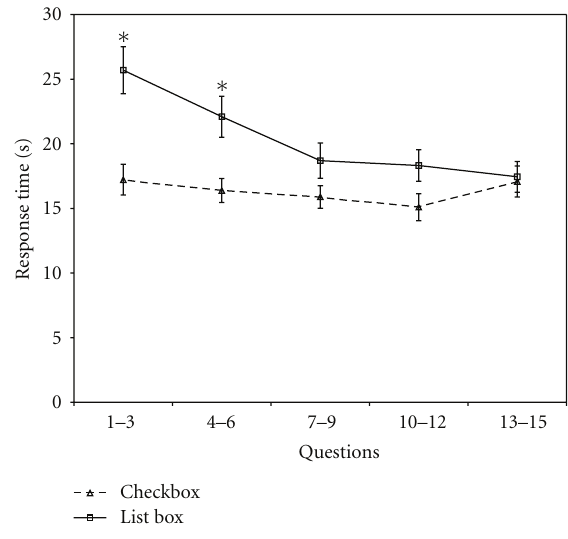
Figure 3: Mean response time and standard error for checkboxes and list boxes (significant di ff erences are flagged with an